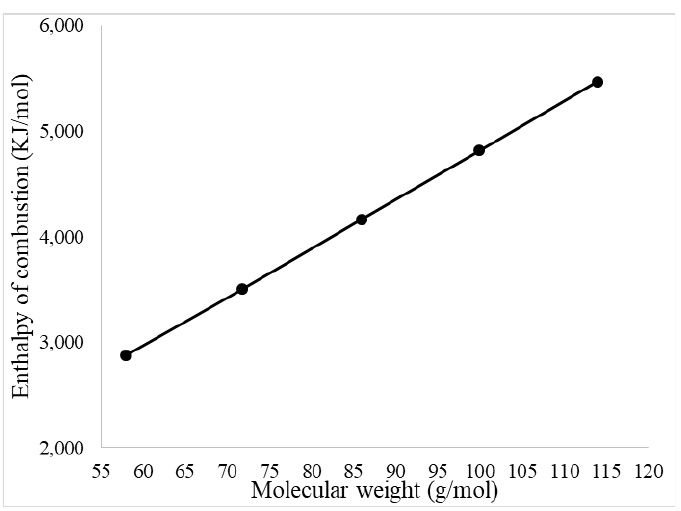
Figure 9. The effect of weight percentage of CHO on enthalpy of combustion for aldehydes .